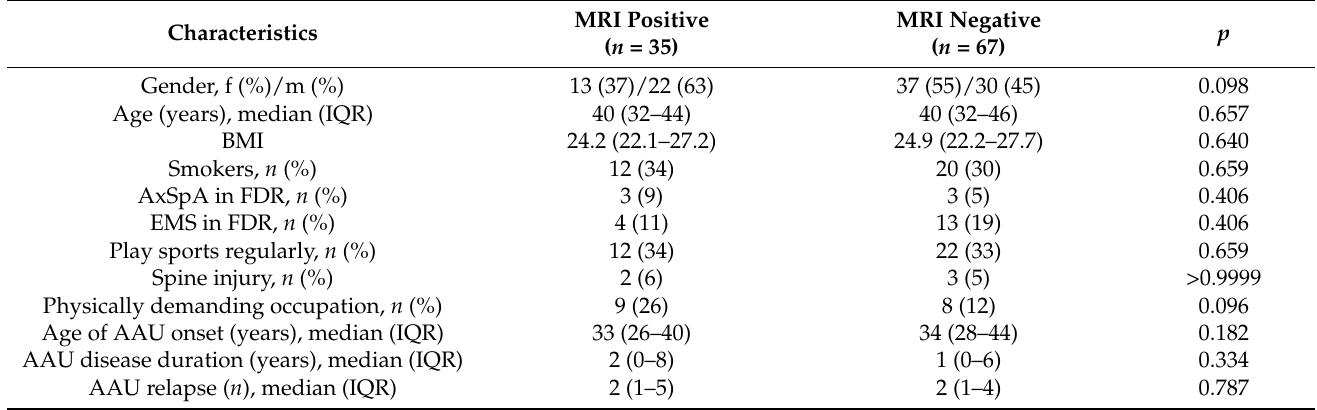
Table 2. Clinical characteristics of patients with anterior uveitis and MRI defined sacroiliitis (positive) and without MRI defined sacroiliitis (negative). Bold shows statistically significant